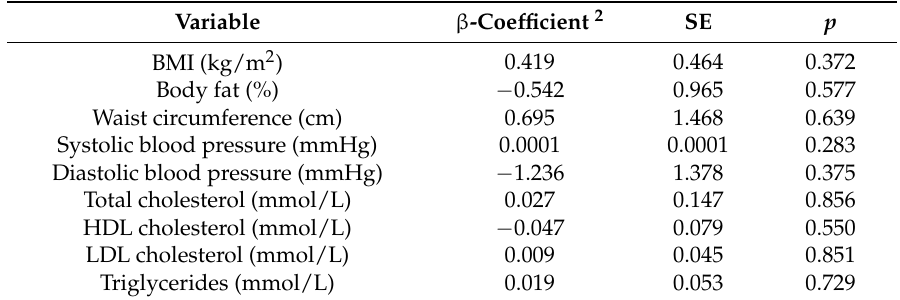
Table 3. Linear regression analysis results for CVD risk markers with Healthy Lifestyle Score in